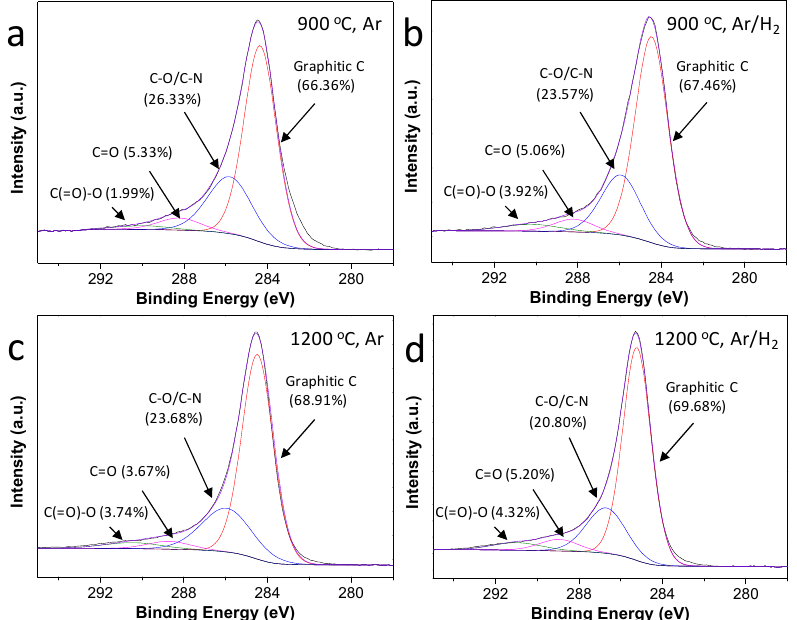
Figure 2. High resolution XPS of C 1s peak of (N)G pyrolyzed at 900 ◦ C under Ar ( a ) or Ar / H 2 (5%) ( b ) and pyrolyzed at 1200 ◦ C under Ar ( c ) or Ar / H 2 (5%) ( d ).